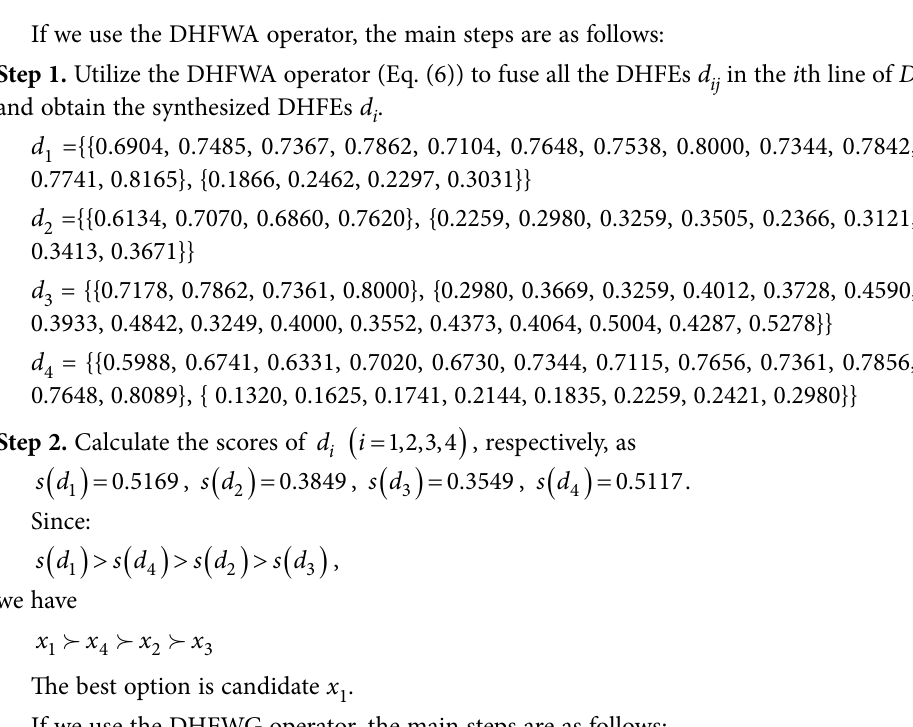
Table 1. Evaluation information x